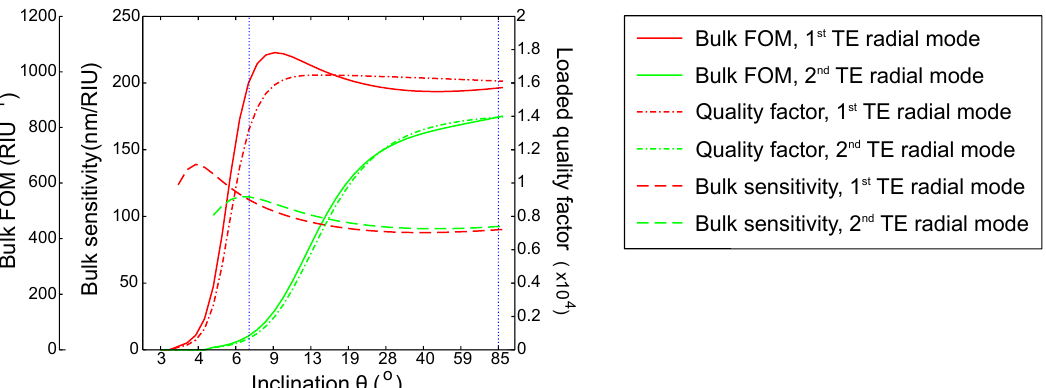
Figure 5. Quality factor (dashed-dot line), bulk sensitivity (dashed line) and bulk FOM (continuous line) for the first (red) and second (green) TE radial modes. The vertical blue lines are markers for the parameters of the fabricated sensors (wedge and disk resonators). The resonator thickness is t = 350